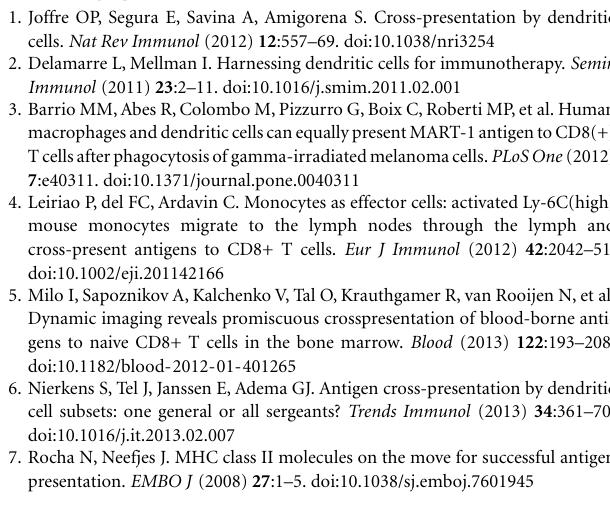
FIGURE 2 | Immunotherapeutic strategies to enhance anti-tumor immunity . Generation of a large pool of effectorTA-specificT cells is induced by the intradermal injection of anti-tumor vaccines.Targeting of the vaccine to a particular skin DC subset is facilitated by modification with specific glycans that bind either to DC-SIGN or Langerin. Subsequent vaccine internalization induces presentation ofTA-Ag and maturation of the DCs. Matured DCs migrate to draining lymph nodes to primeTA-specific CD8 + T cells and CD4 + T helper cells, leading to a large pool of cytotoxic effectorT cells that are capable to infiltrate the tumor lesion and lyse tumor cells. Priming ofTA-specificT cells may be enhanced by inclusion of